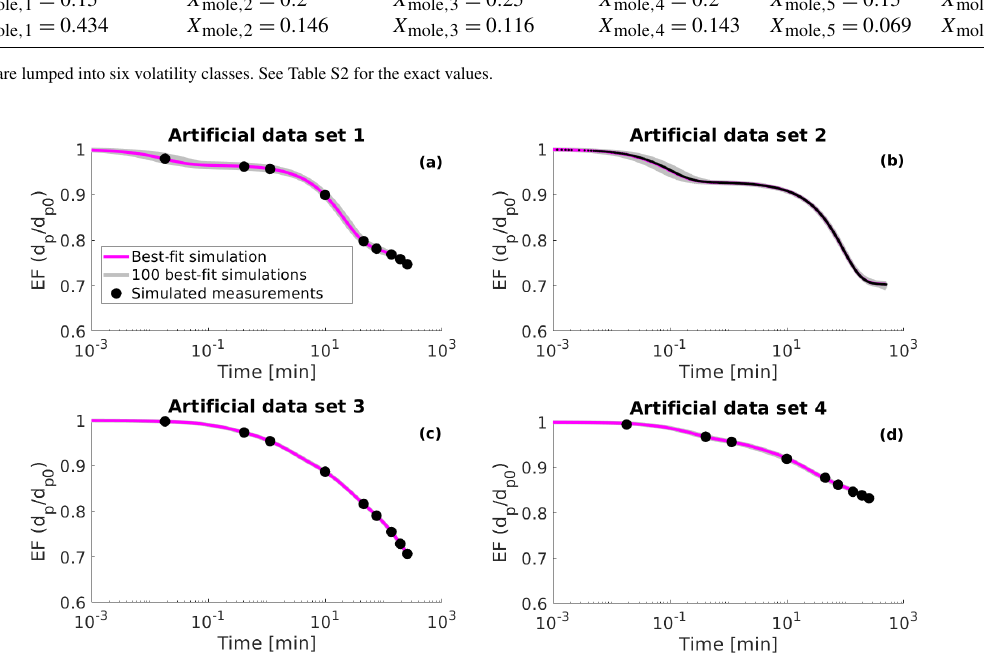
Figure 1. Simulated evaporation factors (EF, particle diameter d p divided by the initial diameter d p0 ) (black circles), 100 best-fit simulations (grey lines) and the best-fit simulation (magenta line) for (a) artificial data set 1, (b) artificial data set 2, (c) artificial data set 3 and (d) artificial data set 4. The best-fit simulation is determined as the evaporation simulation that produces the smallest mean squared error relative to the measurement